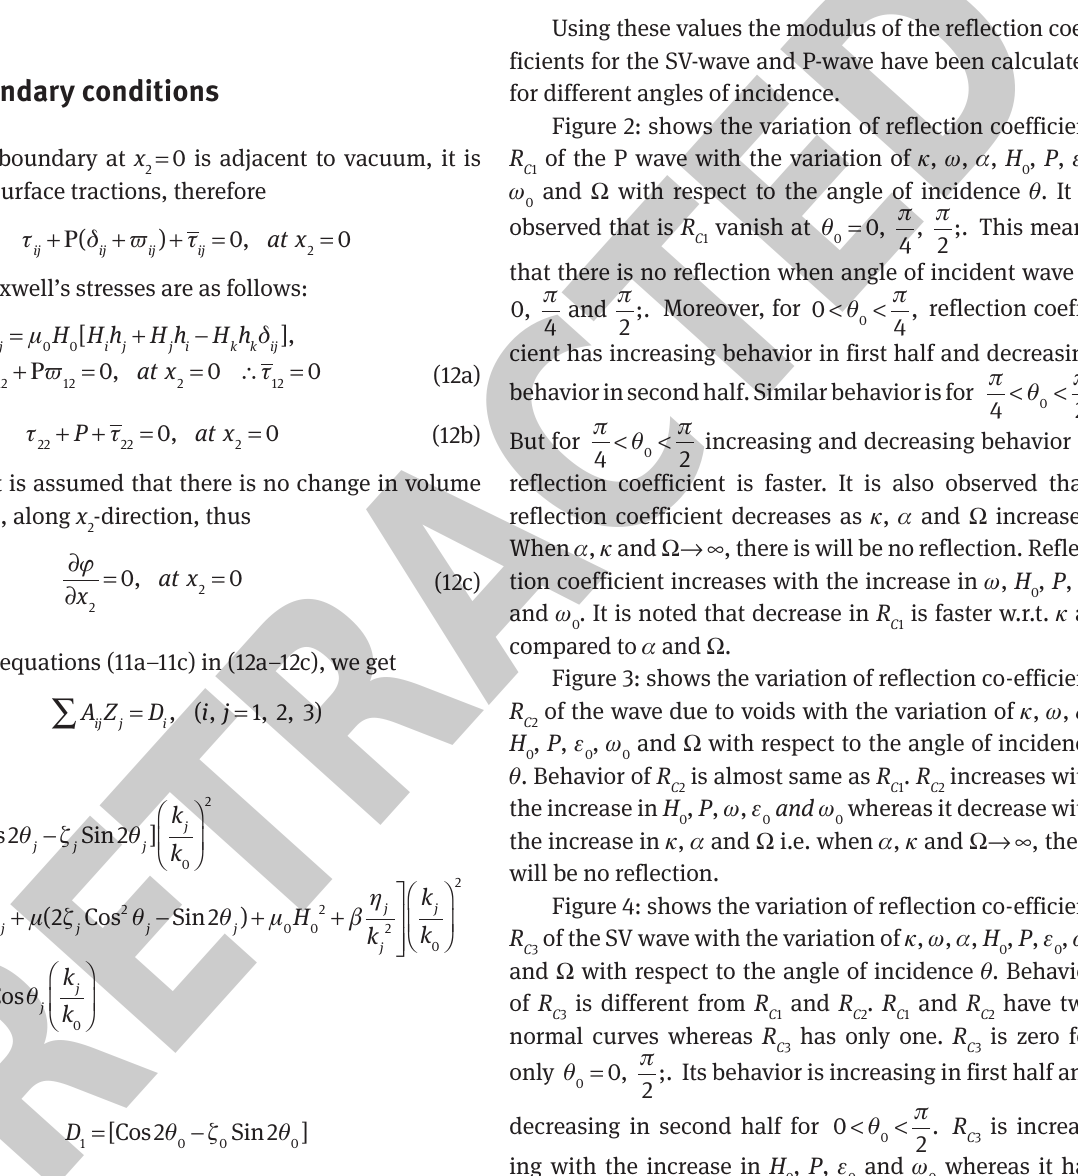
Figure 3: shows the variation of reflection co-efficient R of the wave due to voids with the variation of κ , ω , α , C 2 H , P , ε , ω and Ω with respect to the angle of incidence 0 0 0 θ . Behavior of R is almost same as R . R increases with C 2 C 1 C 2 the increase in H , P , ω , ε and ω whereas it decrease with 0 0 0 the increase in κ , α and Ω i.e. when α , κ and Ω→ ∞ , there will be no reflection. Figure 4: shows the variation of reflection co-efficient R of the SV wave with the variation of κ , ω , α , H , P , ε , ω C 3 0 0 0 and Ω with respect to the angle of incidence θ . Behavior of R is different from R and R . R and R have two C 3 C 1 C 2 C 1 C 2 normal curves whereas R has only one. R is zero for C 3 C 3 π θ = 0, ;. only Its behavior is increasing in first half and 0 2 π θ < < decreasing in second half for R is increas- 0 . C 3 0 2 ing with the increase in H , P , ε and ω whereas it has 0 0 0 decreasing behavior with the increase in α , κ , ω and Ω . It is observed that increase in R w.r.t. H is faster as com- C 3 0 pared to P , ε and ω and decrease in R w.r.t κ , Ω and ω is 0 0 C 3 faster as compared to α and Ω